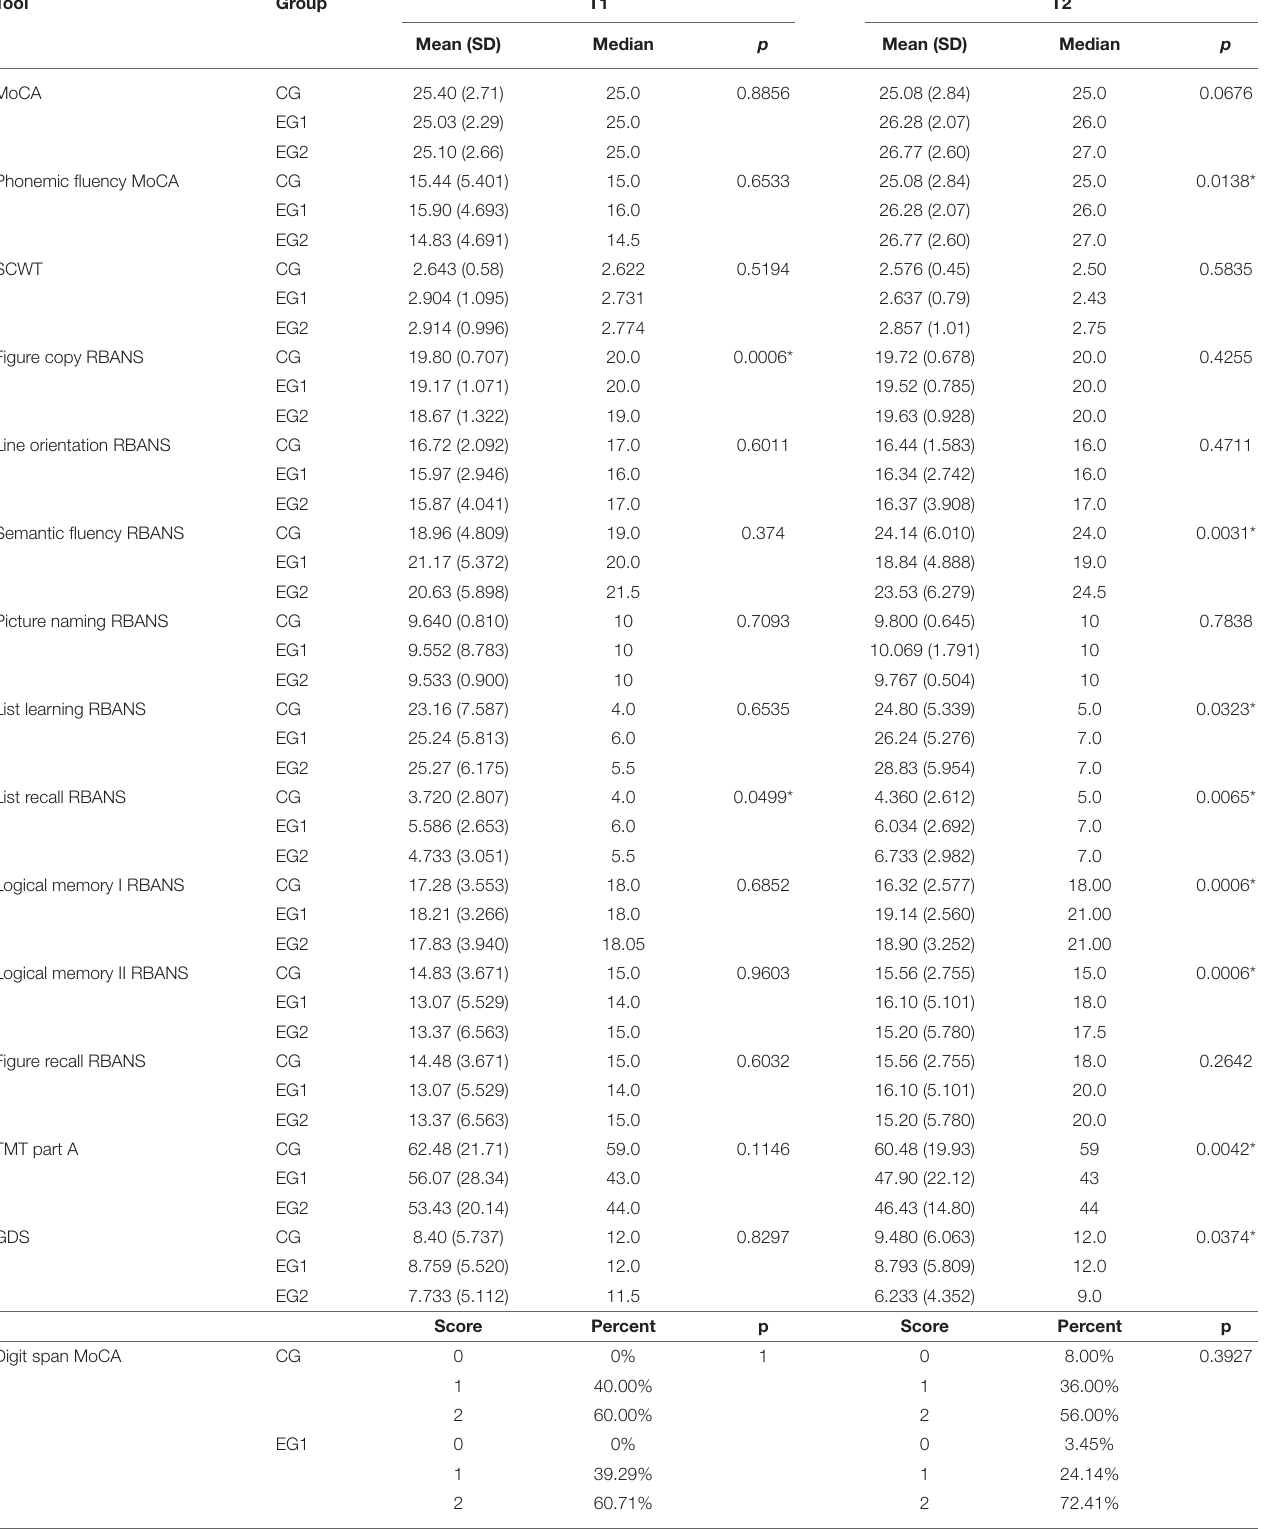
TABLE 2 | Primary and secondary outcome measures obtained in baseline and follow-up.